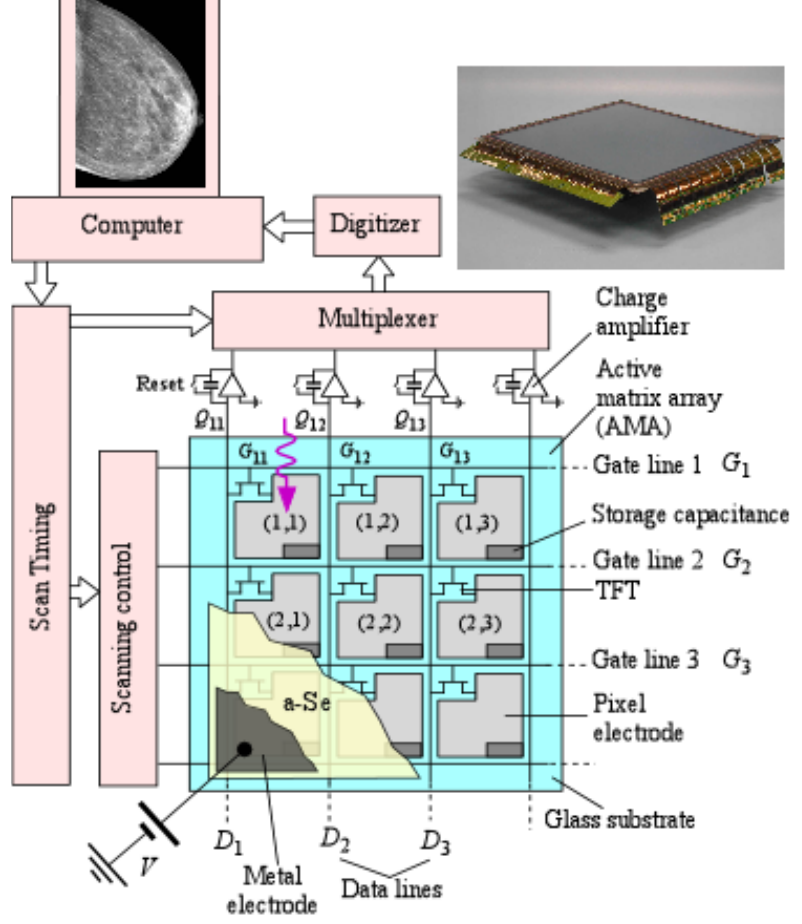
Figure 1. A simplified schematic illustration of a FPXI and its peripheral electronics that drive the sensor operation. At its base, the FPXI has a TFT-AMA with M × N number of pixels (e.g., 2,816 × 3,584) as a substrate. There is an x-ray photoconductor (a-Se) deposited on the AMA, and a top electrode to apply a voltage to the photoconductor. The x-rays absorbed in the a-Se layer above pixel (1,1) generate charges that drift and become collected and stored on the storage capacitor C at this pixel. If a signal is applied to the 11 gate G of the TFT at pixel (1,1), by activating the gate line G , it conducts (it switches 11 1 on) and the charge Q on C is transferred to the data line and hence to the external 11 11 electronics. Data lines feed into charge amplifiers. The C and TFT structures are not 11 inside the glass substrate but on the surface of the glass substrate as indicated in Figure 2. The activation of the gate line G allows the charges Q , Q , Q etc. to be read at the 1 11 12 13 same time to a multiplexer and then onto a digitizer etc . At the end the read-cycle for the 1st row, the 2nd row is addressed via G and so on until all the rows are sequentially 2 addressed, and hence the whole image is read